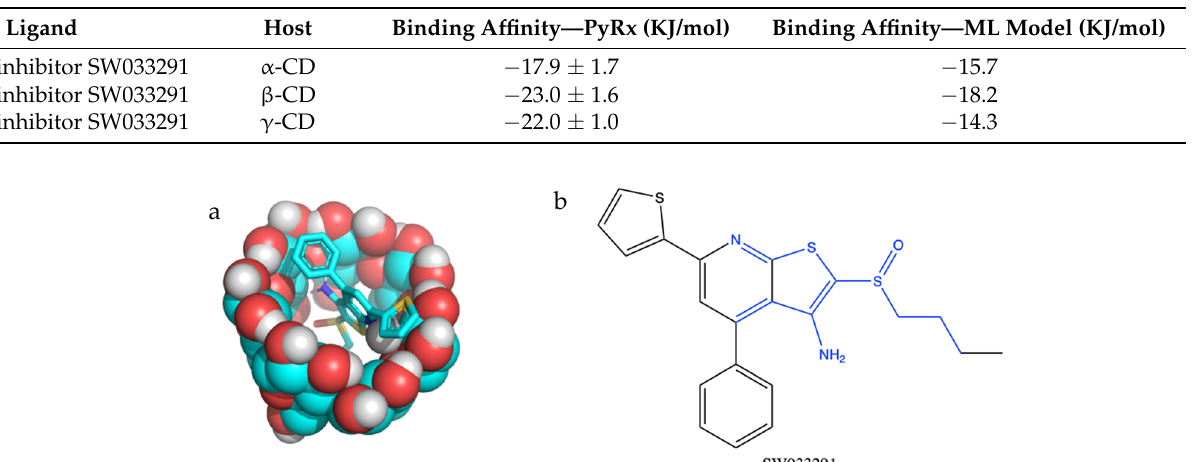
Table 1. Affinity binding simulations of 15-PGDH inhibitor SW033291 (CID:337839) complexation with α , β , and γ cyclodextrin (CD) in both PyRx and a machine learning algorithm for affinity prediction [17].